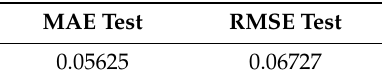
Table 7. The results of the errors in predicting the Ni(II) remove e ffi ciency using the second order regression